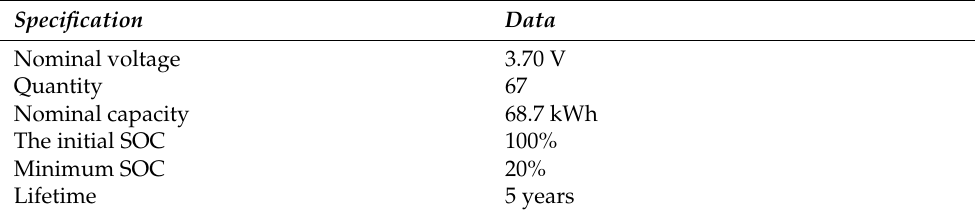
Table 3. Technical specification of BES. Table 2. Technical specification of PV system. Table 2. Technical specification of PV system. Table 2. Technical specification of PV system.